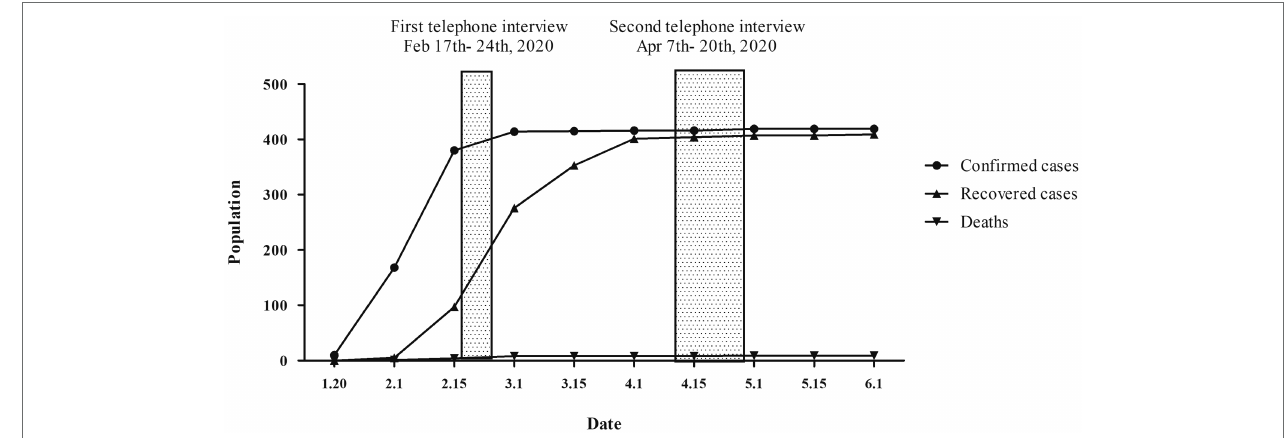
FIGURE 1 | The epidemic trend of the 2019 coronavirus disease (COVID-19) in Beijing from January 10th to June 1st